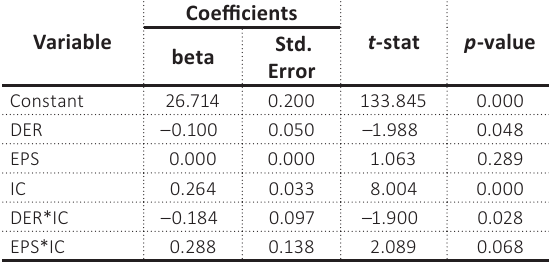
Table 4. Moderation regression analysis test result